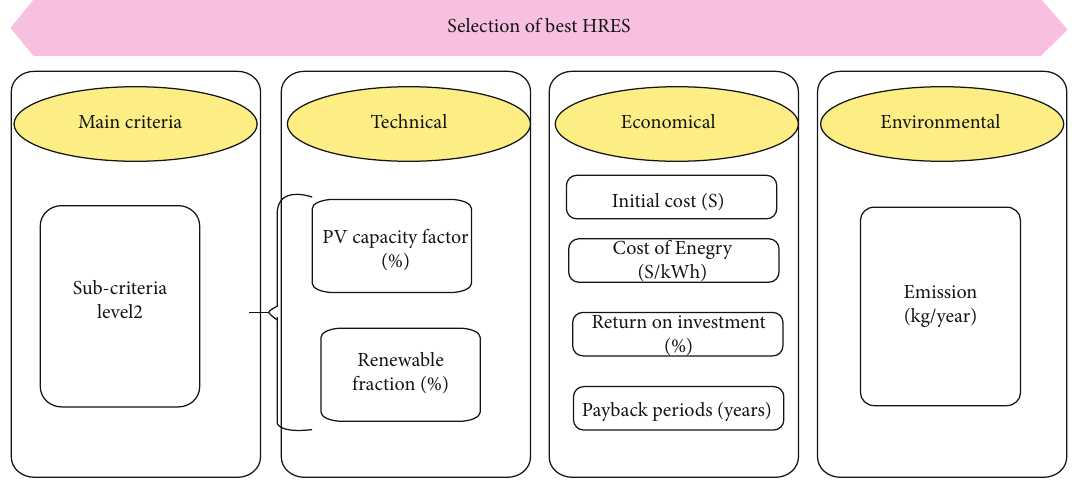
Figure 8: Framework of MCDA model for the present case Table 5: Scale of other criteria with best criteria.